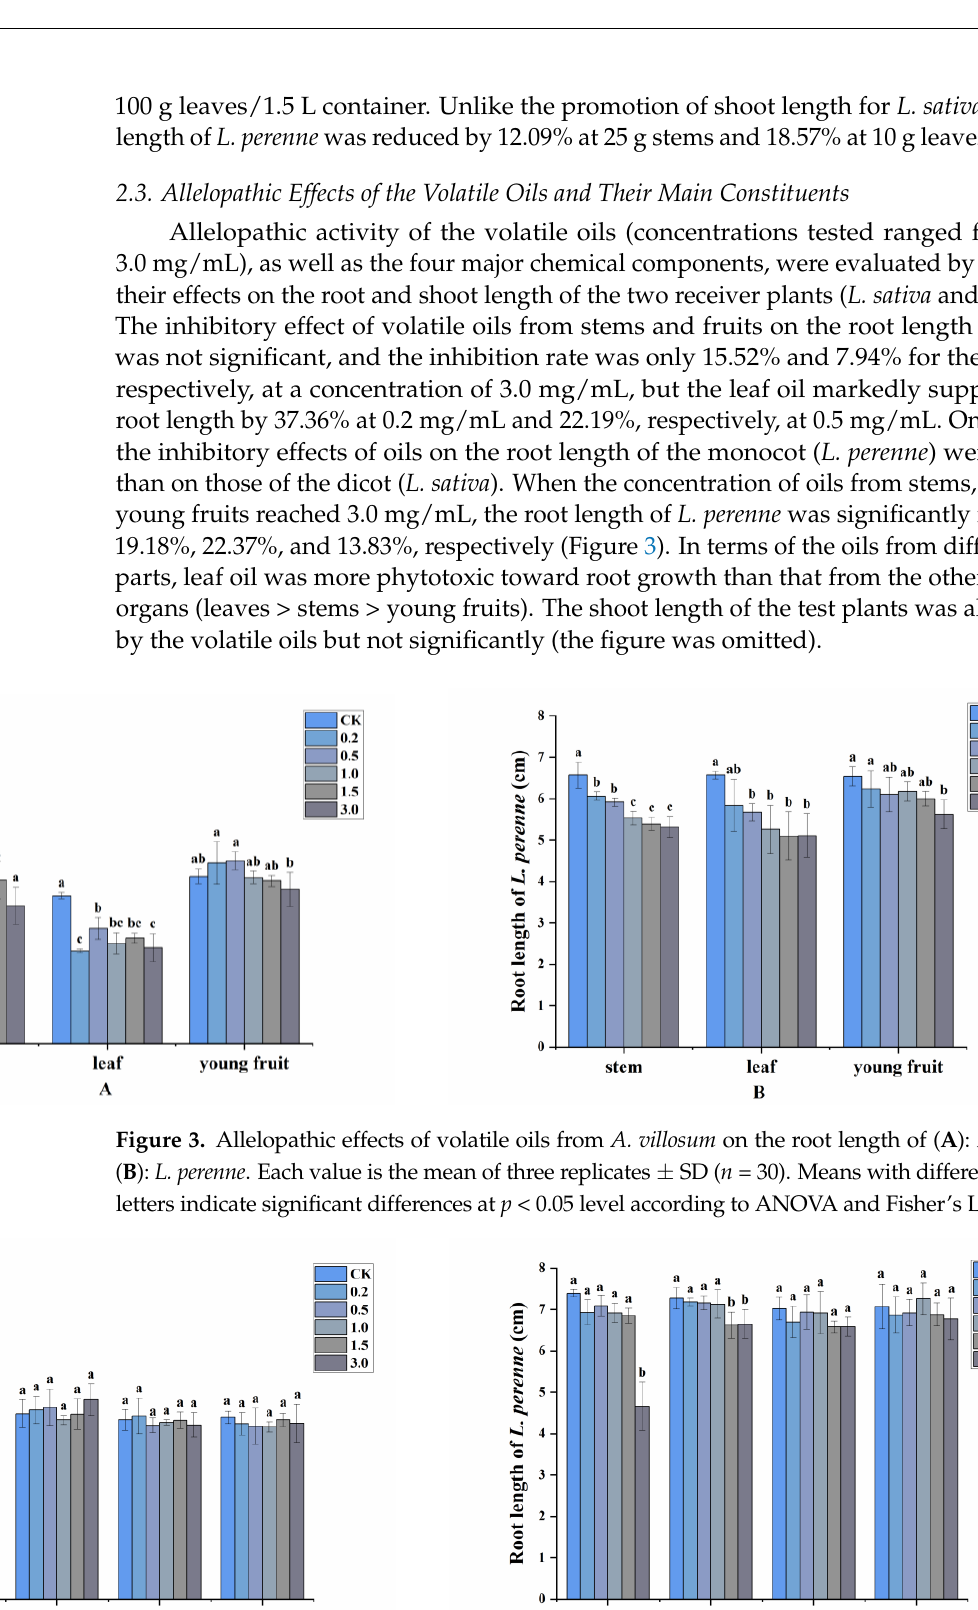
Figure 2. Allelopathic effects of A. villosum volatile compounds on the shoot length of ( A ): L. sativa and ( B ): L. perenne at 0 g/1.5 L (control, CK), 10 g/1.5 L, 25 g/1.5 L, 50 g/1.5 L and 100 g/1.5 L. Each value is the mean of three replicates ± SD ( n = 30). Means with different lowercase letters indicate significant differences at the p < 0.05 level according to ANOVA and Fisher’s LSD test.